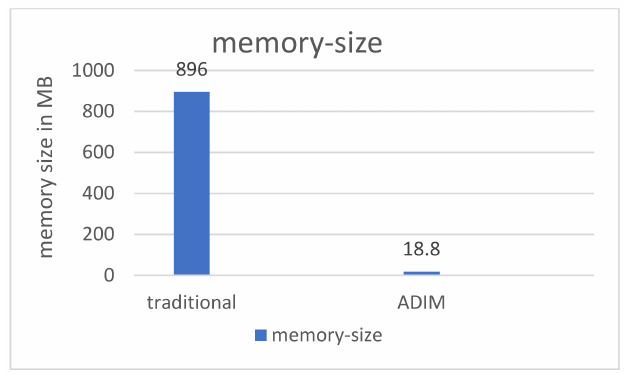
Figure 9. Memory space for document indexing.